Question: From the figure, is the trend upward or downward?
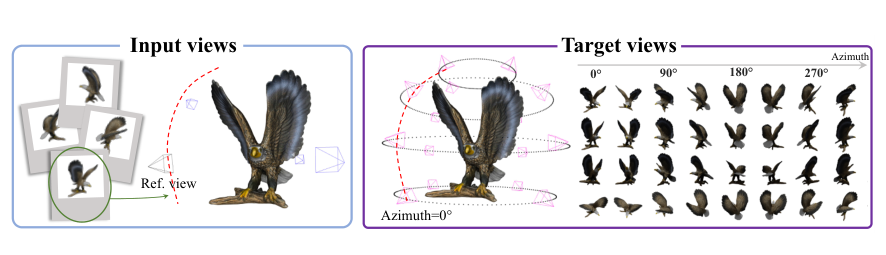
Answer: decreasing